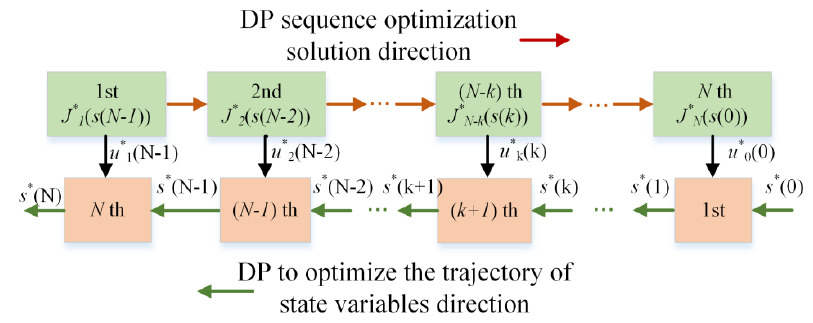
Figure 7. Solution process of dynamic programming algorithm.